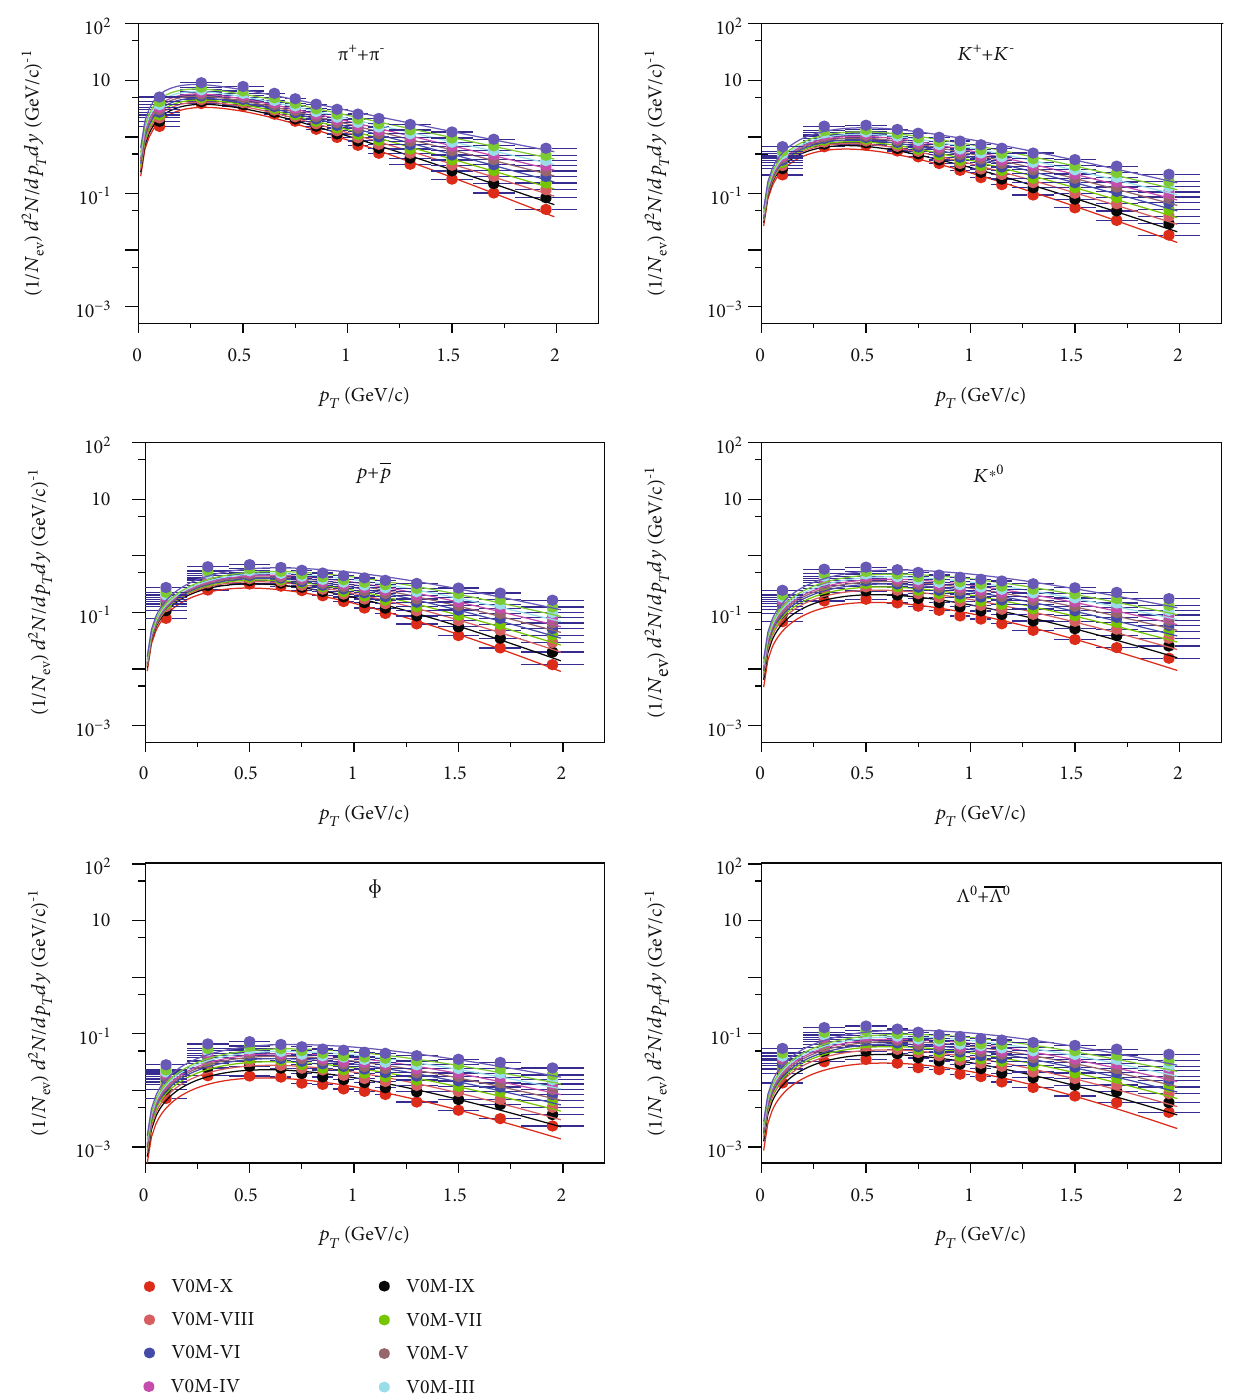
Figure 12: (Color online) Fitting of generated p various multiplicity classes as shown in Table